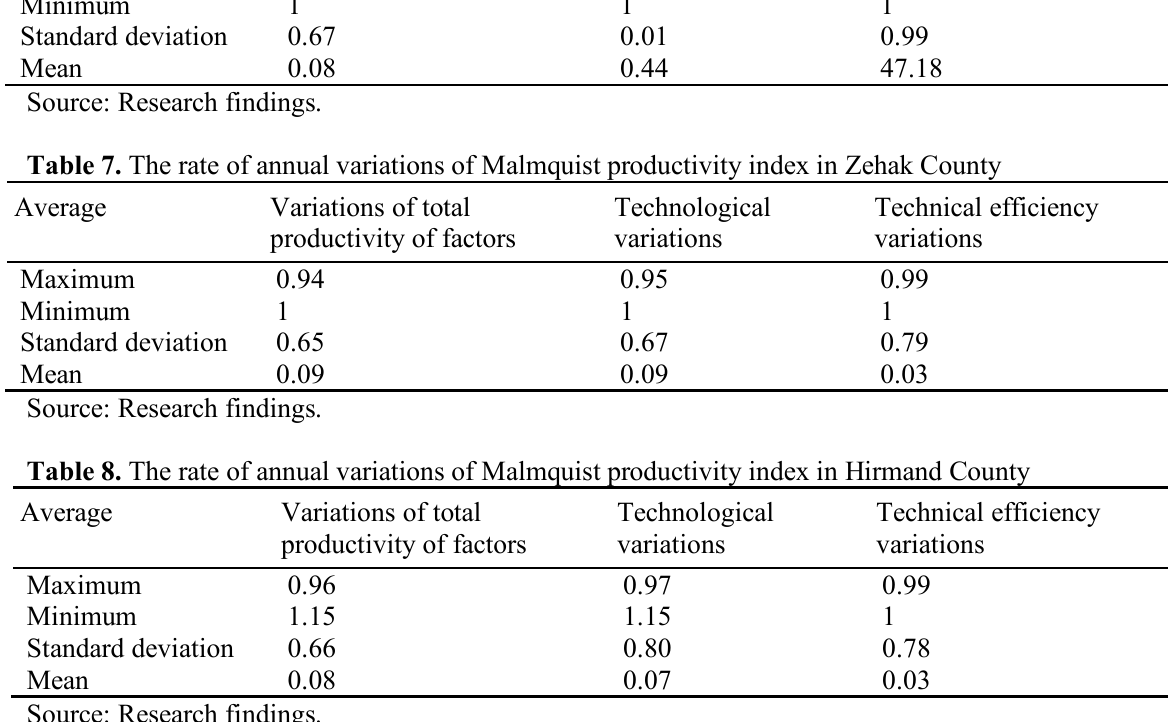
Table 6. The rate of annual variations of Malmquist productivity index in Zabol County Average Variations of total Technological productivity of factors variations variations Maximum